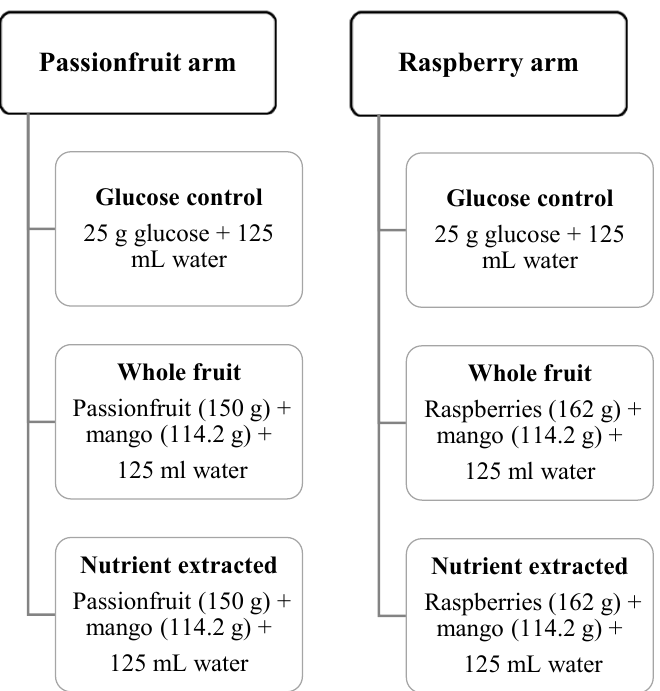
Figure 1. Schedule of planned experiments. Tests completed in random order. Each meal contained 25 g of total